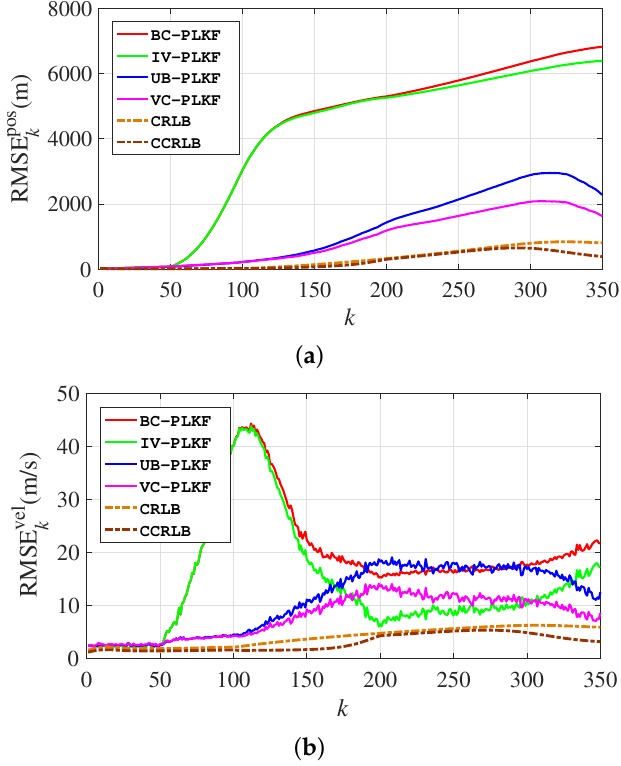
Figure 7. RMSEs for different algorithms in manoeuvring target tracking when there presents the noise statistics mismatch: ( a ) RMSEs for position; ( b ) RMSEs for